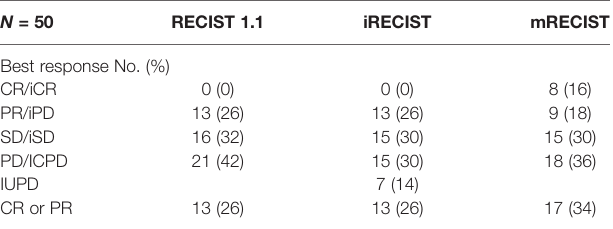
TABLE 4 | Best overall response according to RECIST 1.1, iRECIST, and mRECIST criteria.